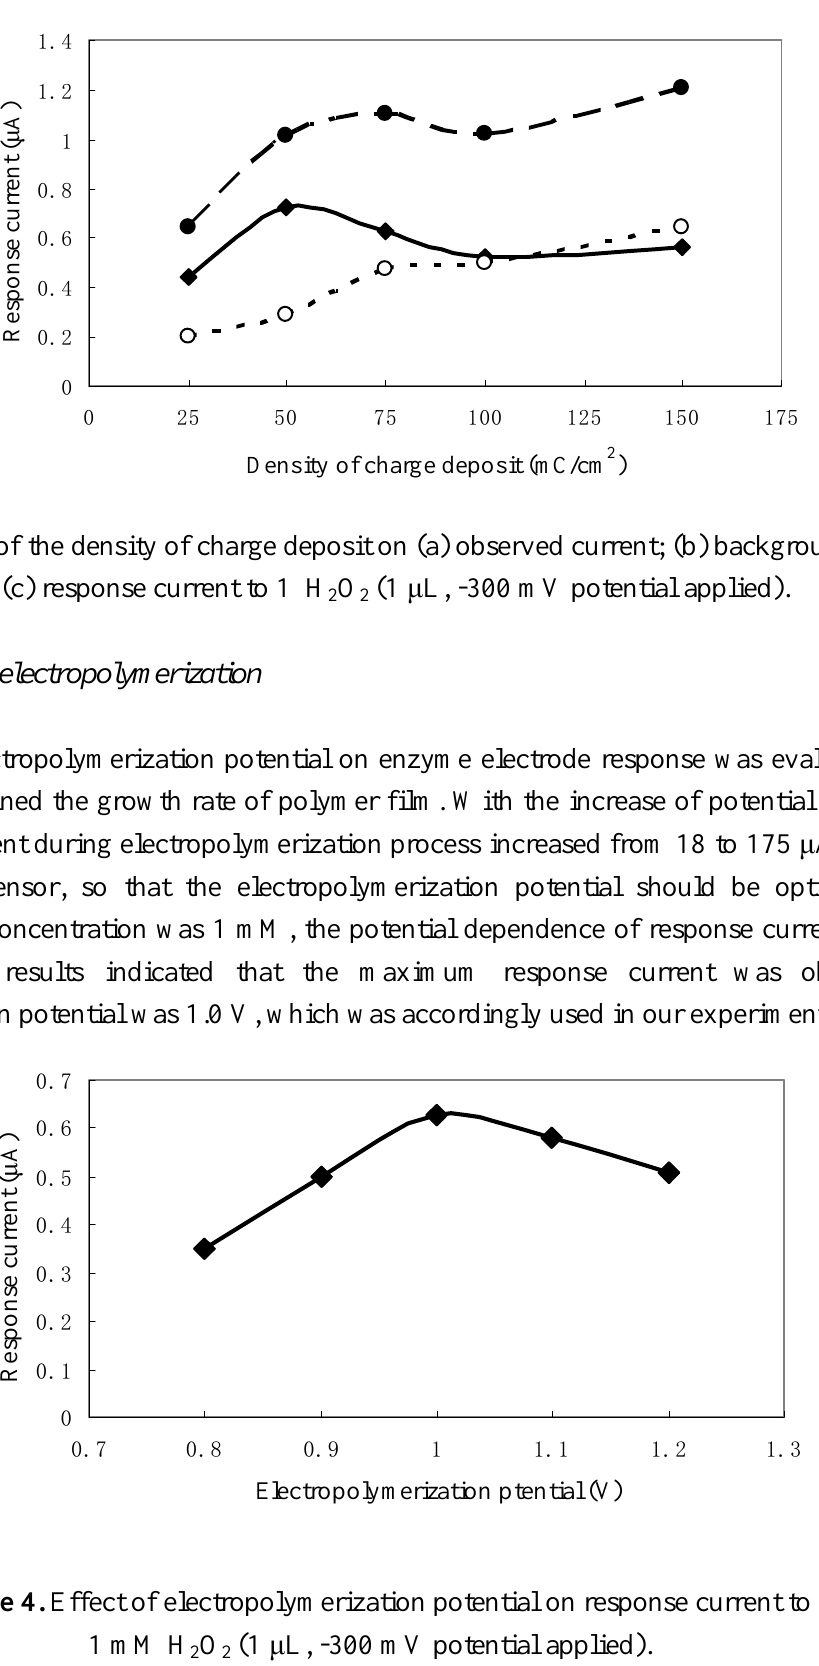
Figure 4. Effect of electropolymerization potential on response current to 1 mM H O (1 µ L, -300 mV potential 2 2